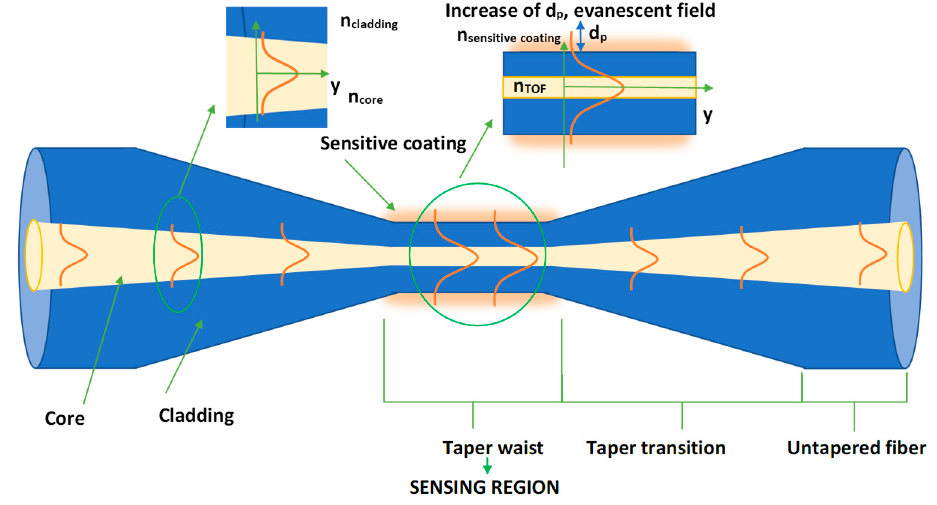
Figure 1. Scheme of the tapered optical fiber with the main region marked and visualization of the change of the propagating wave inside with evanescent field in this region.